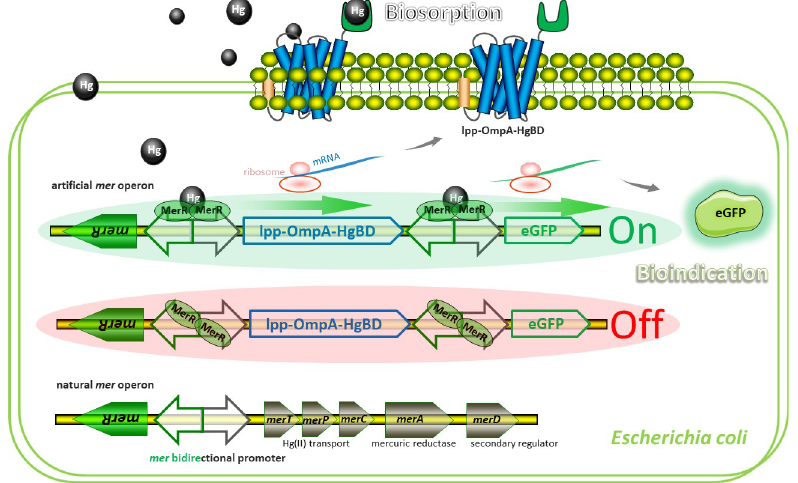
Fig 2. Models for natural and artificial mer operons. Model for artificial mer operon-encoded biosorption and bioindication of Hg(II). The model involves the following proteins: Lpp-OmpA-HgBD, an outer membrane anchoring chimera protein for surface display of metal binding domain derived from MerR; eGFP, a fluorescent reporter. Dimeric MerR bound to the mer divergent promoter activates transcription of the surface-display module and the reporter module in the presence of Hg(II) (top), and represses transcription in the absence of Hg(II) (middle). The archetype of natural mer operon is located on transposon Tn21 from E . coli (bottom). Binding of Hg(II) to dimeric MerR is demonstrated to result in DNA distortion and transcriptional activation of the downstream Hg(II) transport and detoxification genes.